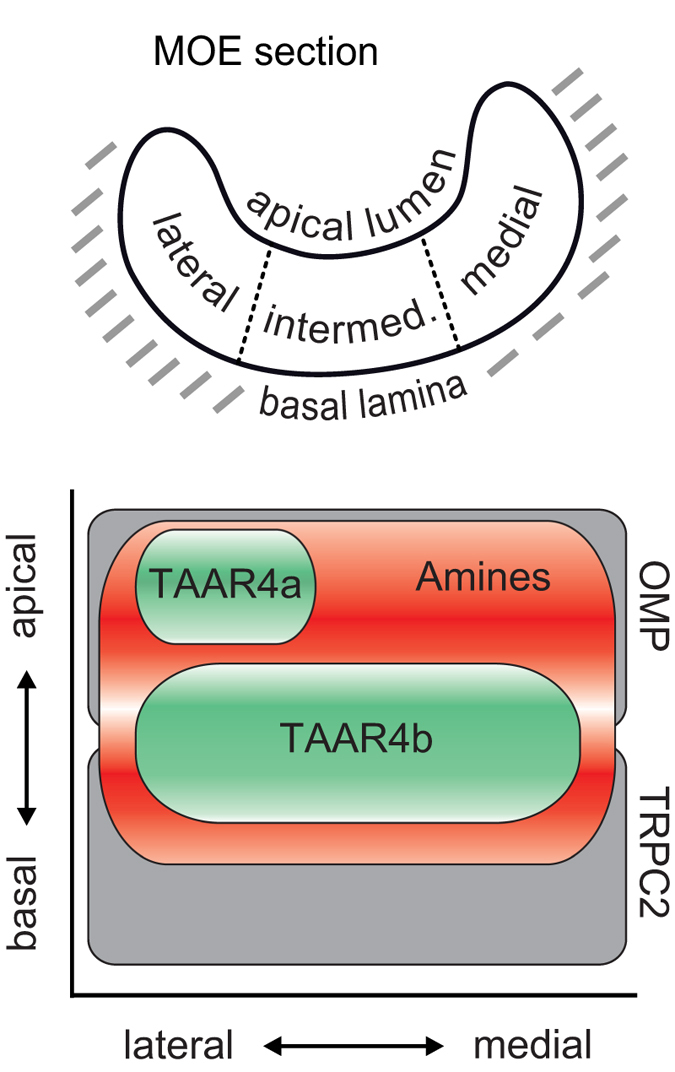
Schematic representation of TAAR4a,4b expression and amine responses.The top panel shows a horizontal section of the MOE of Xenopus laevis as it appears both for measuring odor responses and receptor gene expression. The basalmost layer of the epithelium borders the basal lamina, and the apicalmost layer borders the lumen. The apicalmost layer consists of supporting cells, and the basalmost region of proliferating cells, sandwiching the neuronal region. Perpendicular to this basal-to-apical coordinate, cells in the MOE can also be distinguished by position in the lateral, intermediate, or medial compartment (lateral-to-medial coordinate). The bottom panel depicts a schematic representation of the different cellular distributions analysed. Note that only the neuronal region of the MOE is shown here. Distributions are shown along two axes, basal-to-apical and lateral-to-medial. OMP and TRPC2 distributions are taken from earlier work of our groups24, and are shown for comparison. We emphasize that TAAR4a and TAAR4b differ in both dimensions, and together comprise a large subset of the bimodal amine response region.